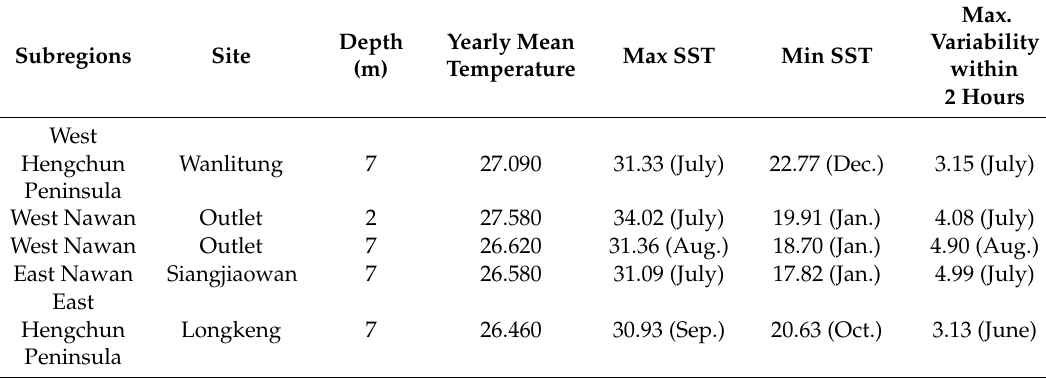
Figure 3. The in situ hourly average seawater temperatures and hourly average temperature di ff erences among Wanlitung (WLT) (7 m deep: a , b ), Outlet (OL) (2 m: c , d ; 7 m: e , f ), Siangjiaowan (SJW) (7 m: g , h ), and Longkeng (LK) ( i , j ) from 1 January 2007 to 1 January 2008. The vertical dotted and solid lines indicate full moon and new moon, respectively. The seawater temperature was recorded using in situ underwater data loggers (Hobo Pendant ® Temperature data logger, Onset Computer Corporation, Bourne, MA, USA). We calculated the hourly average temperature first because temperature was measured at di ff erent time interval, such as every 15 min or every 30 min, among sites. Hourly average temperature di ff erences were defined as the di ff erence in hourly average temperatures between any given hour and the hour next. We used hourly instead of daily average temperature di ff erence in order to reveal the temperature di ff erence caused by TIU instead of day cycle. Table 2. Characteristics of the in-situ temperature record at the five sites from 1 January 2007 to 1 January 2008.